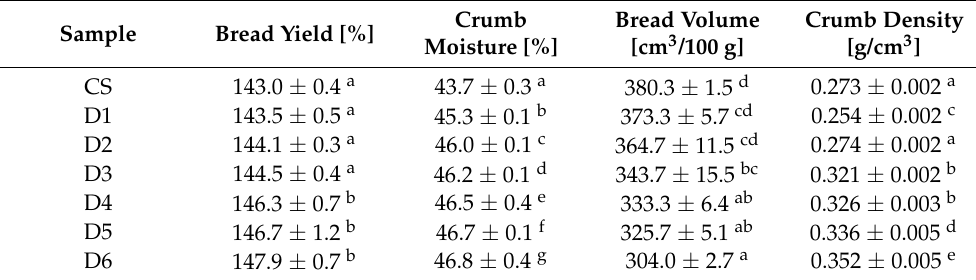
Table 3. Basic characteristics of control and DF-enriched